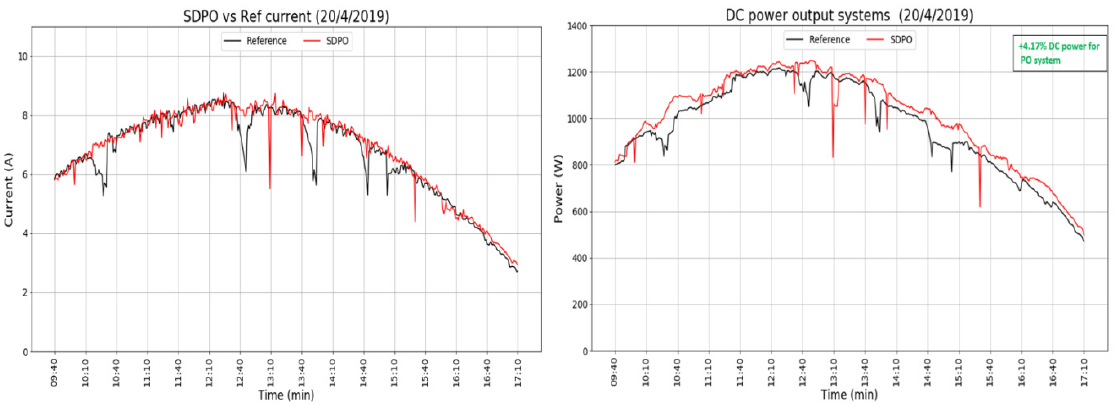
Figure 6. Current and DC power curves of optimized and non-optimized modules during a sunny day under partial shading from a pole.